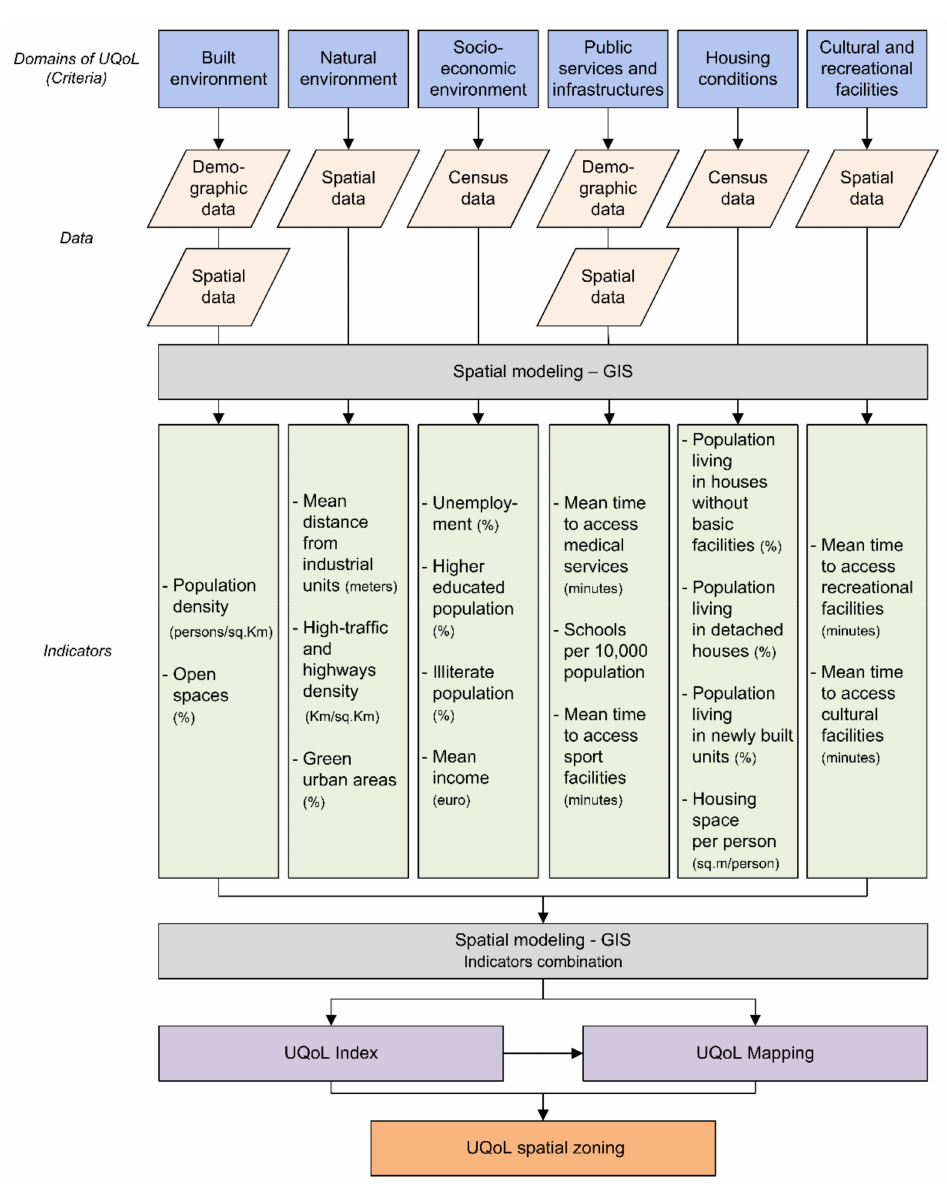
Figure 2. Workflow of evaluating and mapping